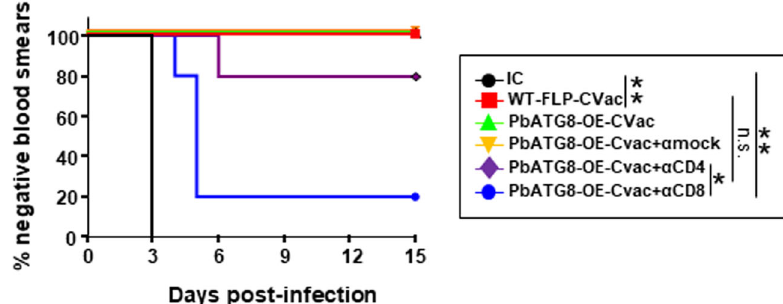
Fig. 6 CD8 + T-cell depletion post-immunization reduces the protective response elicited by PbATG8-OE-CVac. Kaplan – Meier survival plot showing days to blood-stage infection. Swiss-Webster mice were immunized with 2 × 20,000 WT-FLP-CVac or PbATG8-OE-CVac sporozoites. PbATG8-OE-CVac-immunized mice were divided into four groups ( n = 5 in each group). Three groups of mice received intraperitoneally 500 μ g of antibodies per dose: α CD8 (clone 2.43), α CD4 (clone GK1.5), or mock isotype control IgG (LTF-2). Antibody treatments were done twice, 24 h prior to the challenge and on the day of the challenge. Parasitemia was monitored daily following the challenge with 10 4 WT Pb-ANKA sporozoites, * p < 0.05; ** p < 0.01, measured by log-rank Mantel – Cox test. Data are representative of one experiment done